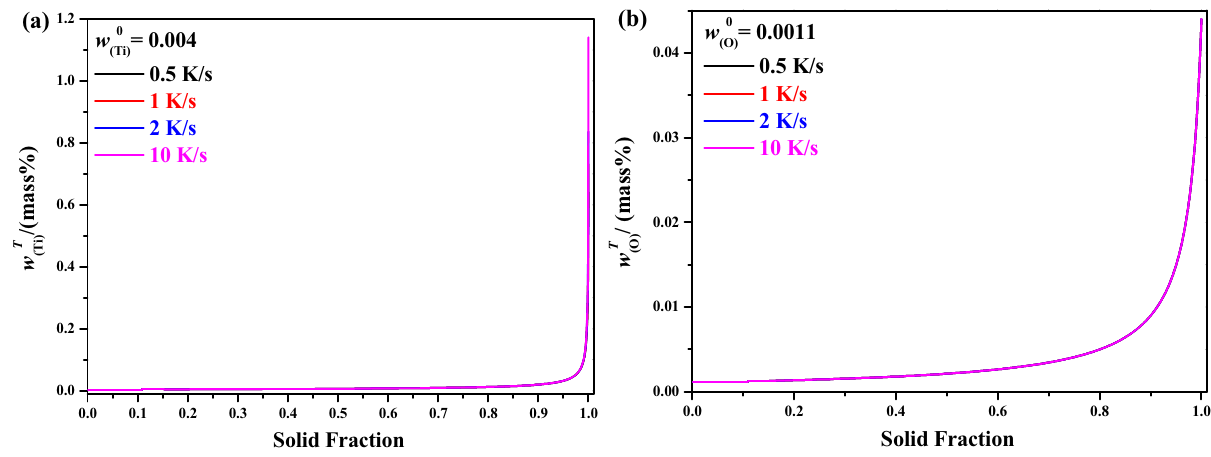
Figure 6: Concentration changes of solute elements Ti and O during the solidification processes.